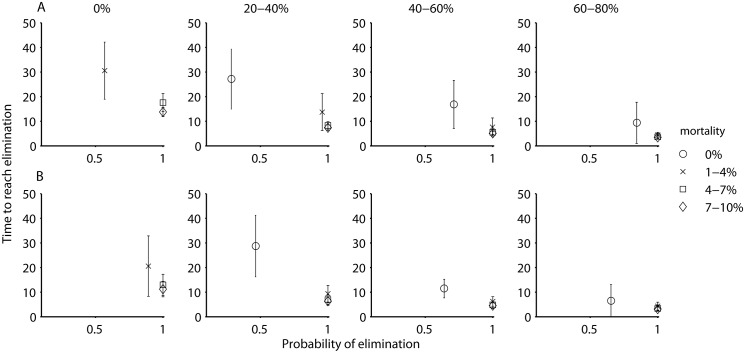
The proportion of simulations where HAT was eliminated (i.e., prevalence < 1 x 10−6) and the mean time to elimination, depending on the percentage of the human population screened per year, with varying levels of vector control (expressed as additional vector mortality, indicated by the symbols in the legend), for a low transmission setting without an animal reservoir (A) and with an animal reservoir (B).